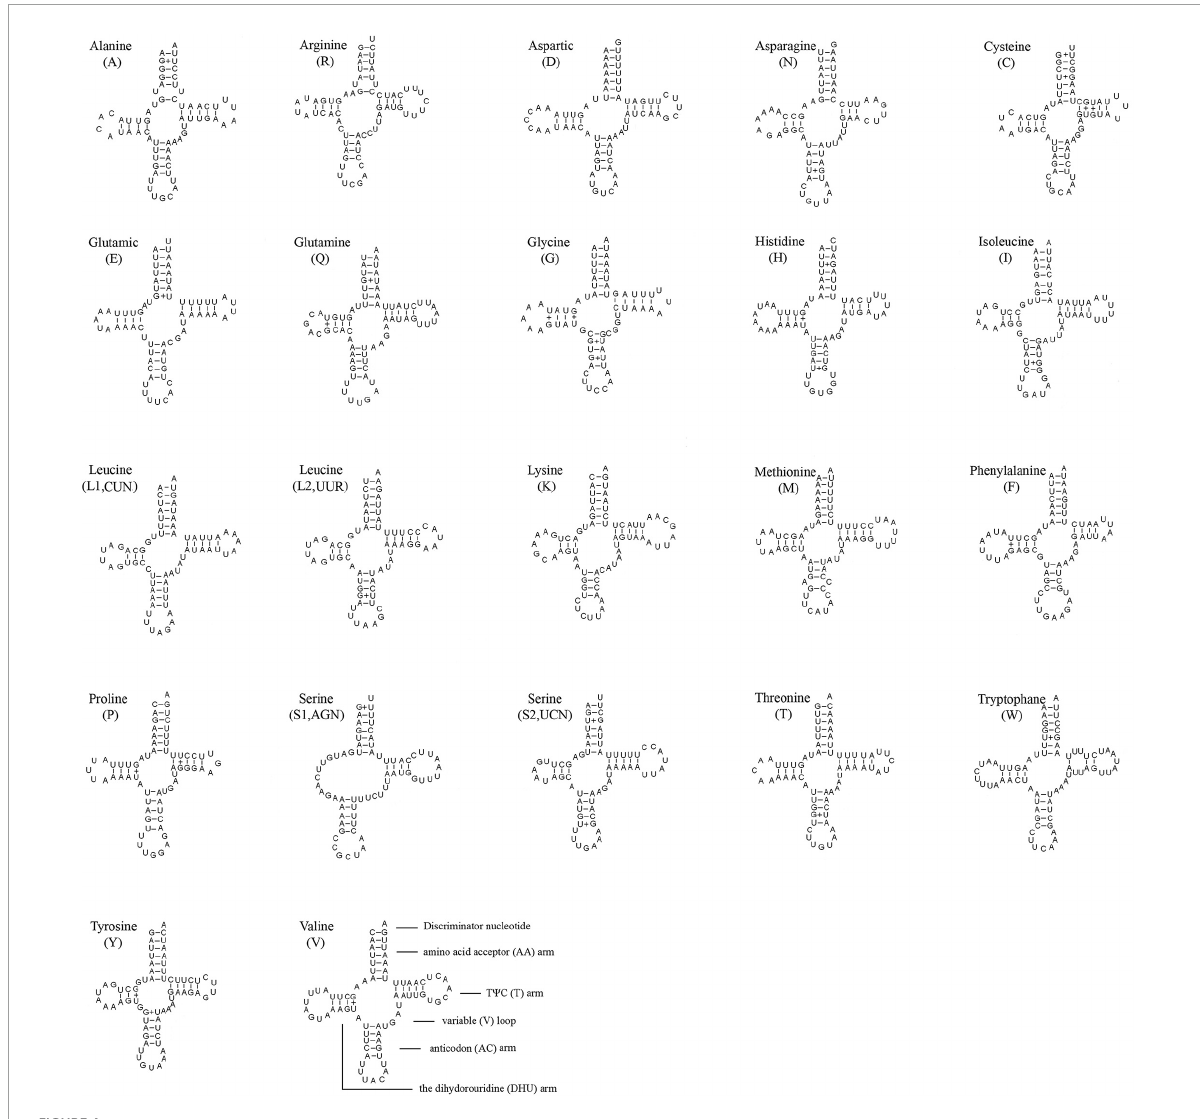
Simuliidae, almost all species used ATN as the start codon for all PCGs, except COI of all species used TTG and ND2 of S. ornatum (subgenus Odagmia ) used TAT. Almost all species used TAA/TAG for the stop codon, except ND1 of S. noelleri (subgenus Simulium ) used T-tRNA, and COI of most species used T-tRNA except S. angustipes (subgenus Eusimulium ),